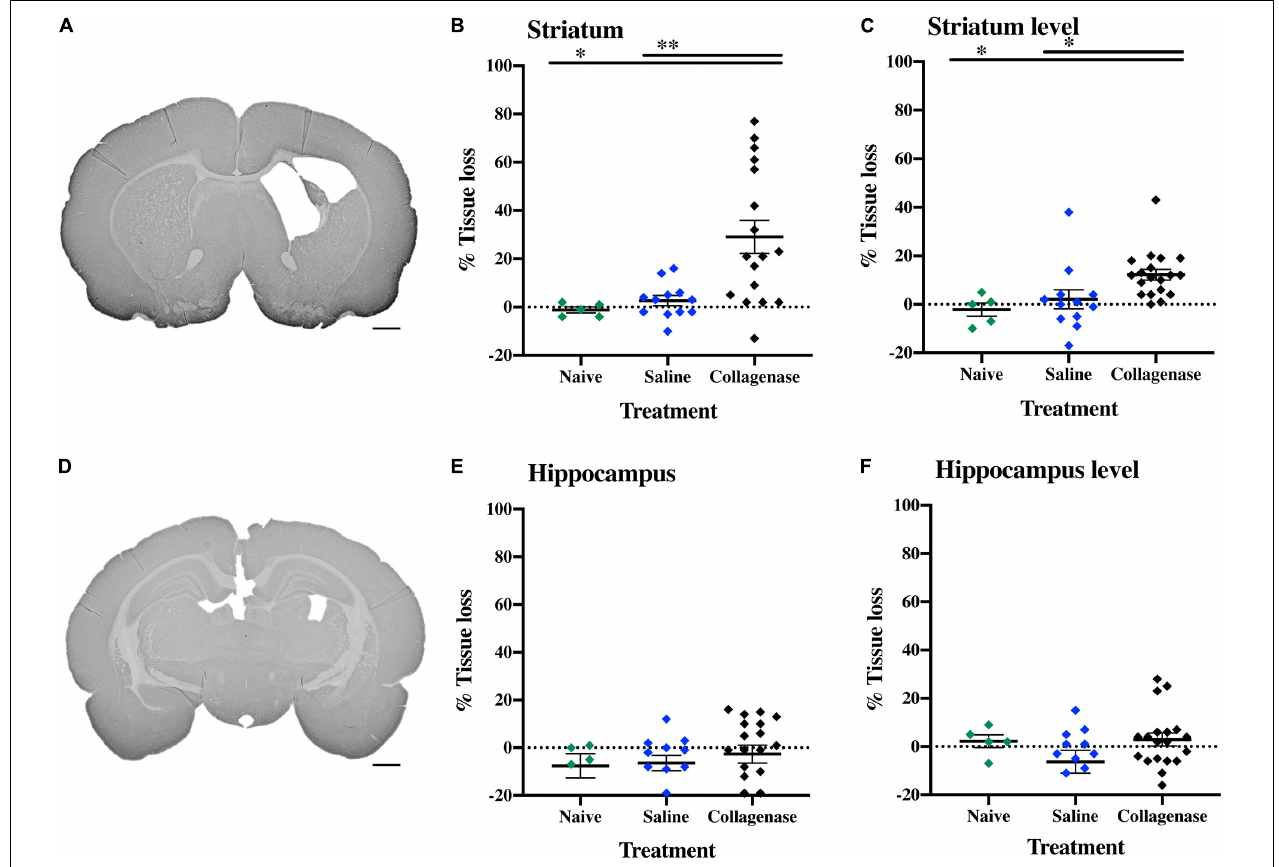
FIGURE 9 | Long term gray matter injury. (A) Representative MAP-2-stained whole brain micrograph of 0.3 U collagenase-mediated striatal injury at P40. (B) Graph demonstrating striatum-specific tissue loss and (C) striatum level ipsilateral hemisphere loss in the collagenase group. (D) Representative MAP-2-stained whole brain micrograph of 0.3 U collagenase-injected rat at the hippocampal level at P40. (E) Corresponding graph revealing non-significant hippocampus-specific tissue loss and (F) hippocampus level ipsilateral hemisphere measurement in the collagenase group ( n = 19). Both naïve ( n = 5) and saline-injected ( n = 12) animals were used as control groups. Data represented as individual animals ± SEM and analyzed using one-way ANOVA followed by Tukey’s multiple comparison test. ∗ P < 0.05 and ∗∗ P < 0.01. Scale bar = 1